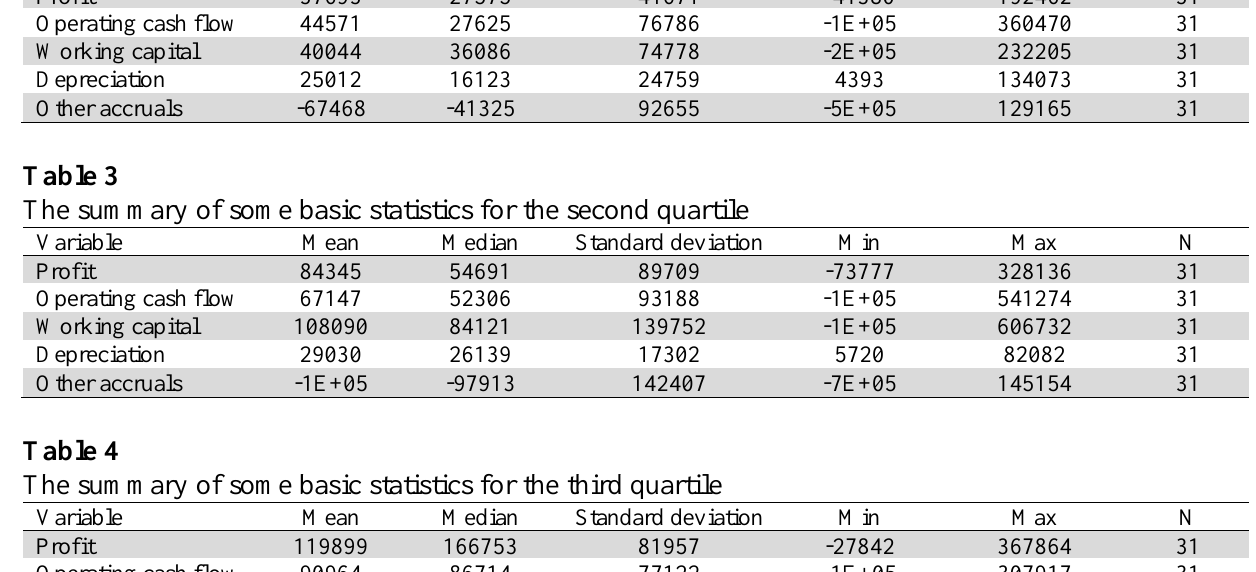
The summary of some basic statistics for the first quartile Variable